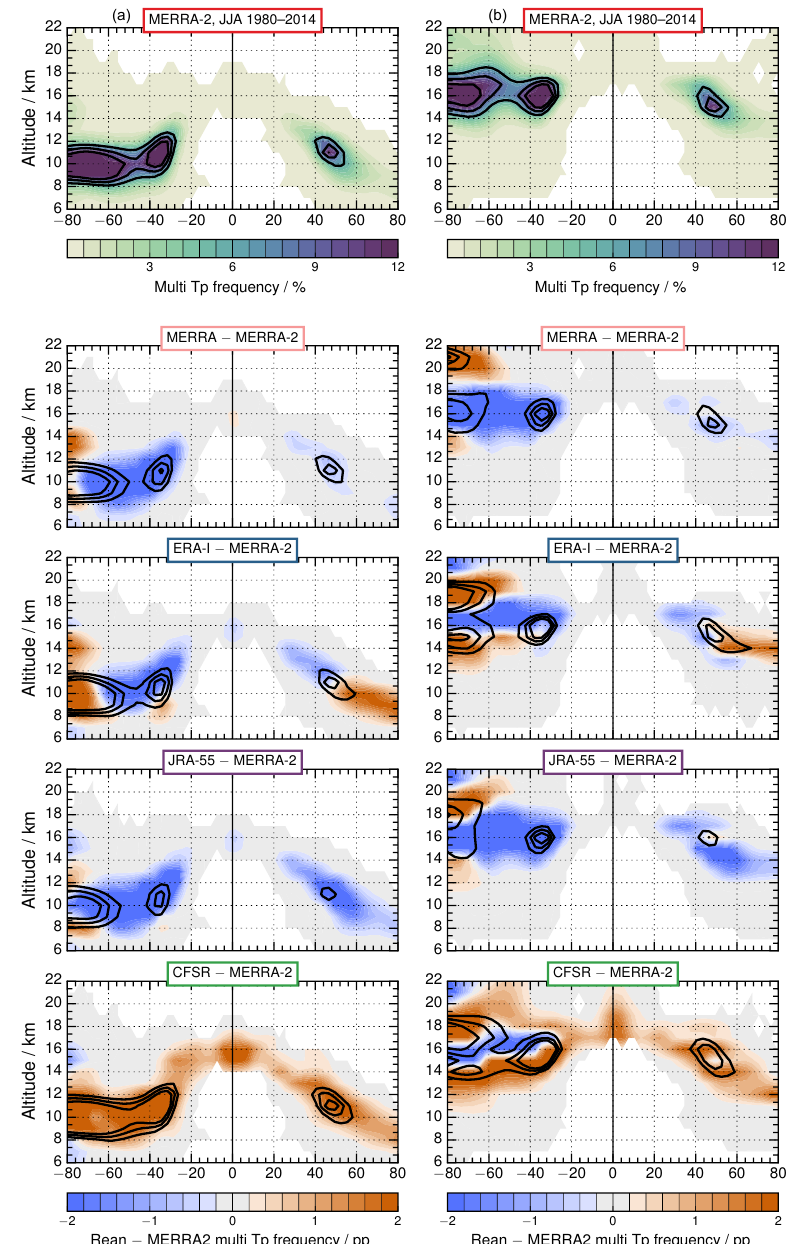
Figure 10. As in Fig. 8, but for multiple tropopause frequency distributions. Primary tropopause frequencies are shown on the left (a) and secondary tropopause frequencies on the right (b) . Overlaid contours are frequencies of 6, 9, and 12%; the smallest value is always the largest or “outermost” contour. In the difference plots, blues/oranges indicate negative/positive differences.